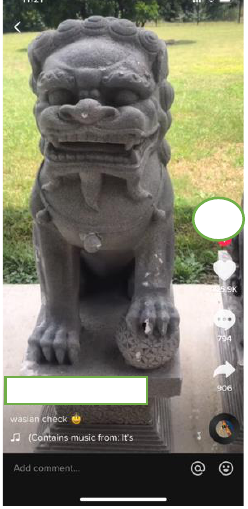
Figure 7. Asian Art Objects.